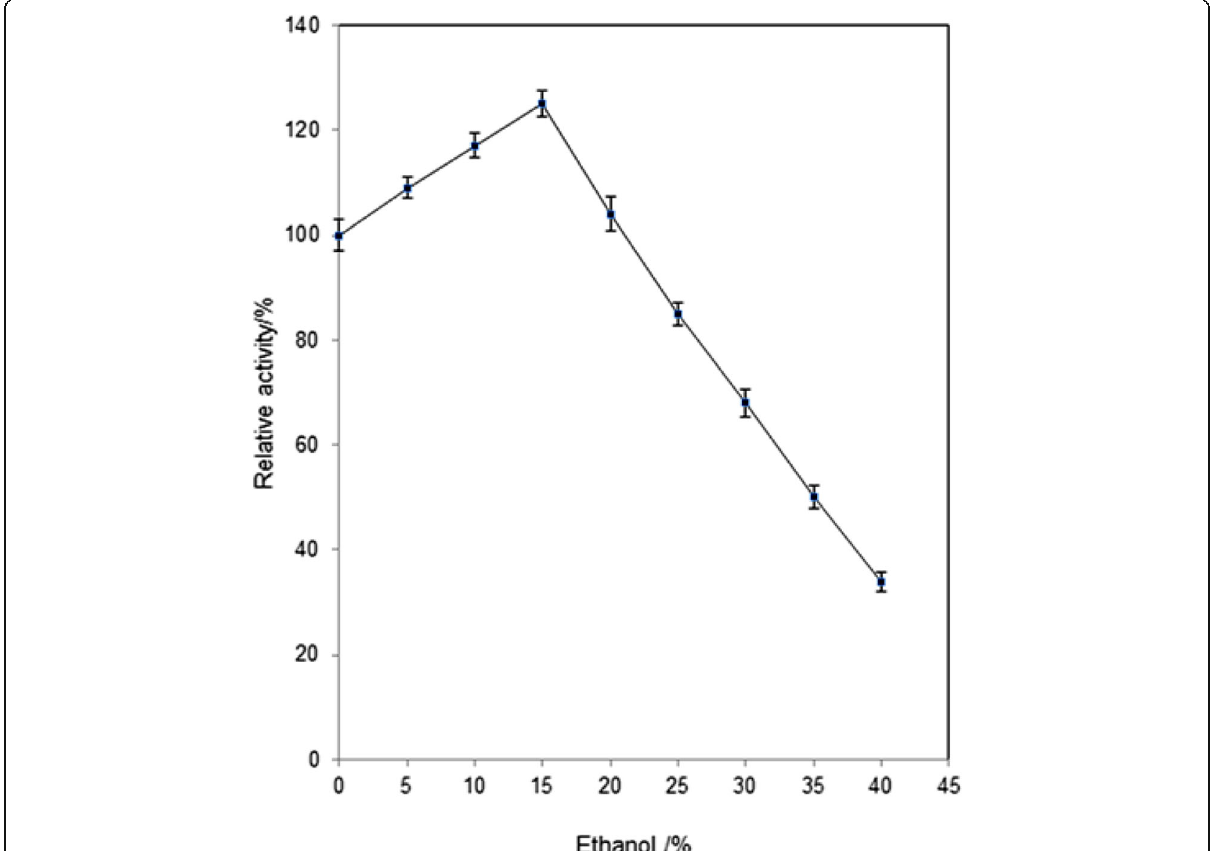
Fig. 7 Influence of ethanol on Aspergillus sp. DHE 7 β -glucosidase activity. Different concentrations of ethanol (0 – 40%) were added to the reaction mixture each containing 20 μ g of β -glucosidase and 5 mM p -NPG in 0.05 M Na-citrate buffer, pH 6.0. All the reaction mixtures were incubated at 60 °C and pH 6.0. The non-treated enzyme activity was regarded as control